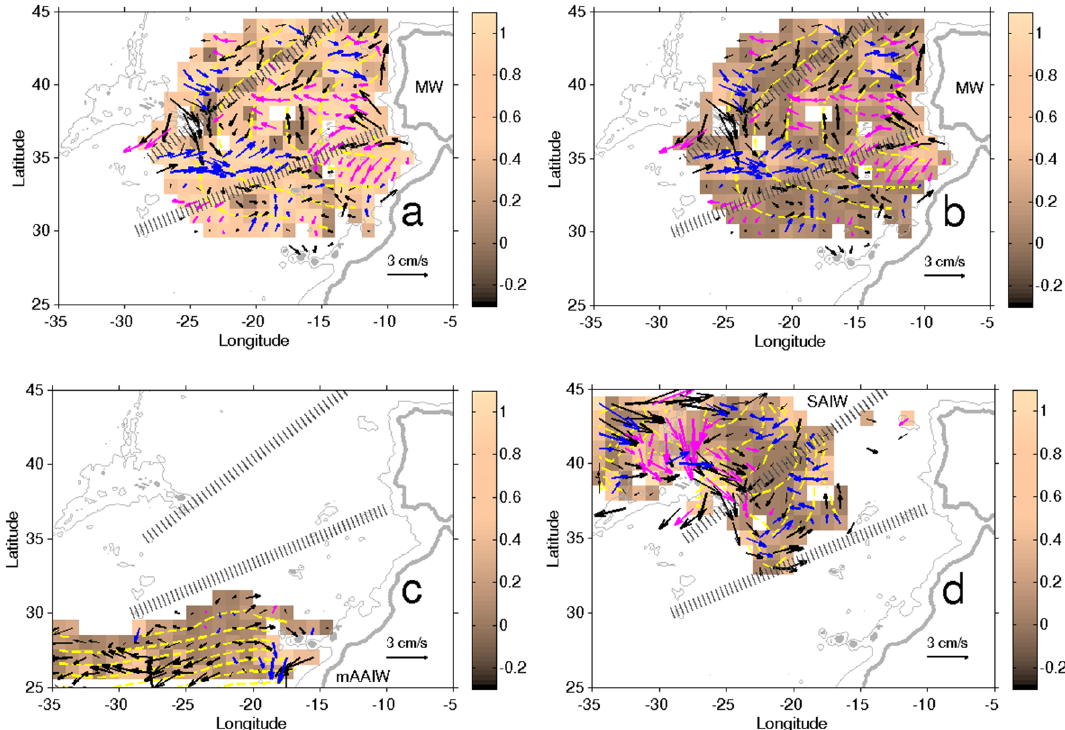
Figure 13. The role of advective and diffusive fluxes in the spreading of water types. Colour in panel (a) is | v/V | over MW; the lighter the shade, the more exact is the advection balanced by the diffusive dispersion of the source water type. Panels (b) , (c) and (d) represent the overall intensity of the diffusive fluxes ( F diff ) for MW, mAAIW and SAIW, respectively. Currents at the core depth of the respective source water type are marked with thin black arrows (the error in definition of the current velocity ranges from 50% to 100%) and thick black/magenta/blue arrows (the error in definition of the current velocity is below 50%). Yellow contours represent isolines of concentration of the respective source water type; see Figs. 5a, 6a and 8a for the absolute values. Black arrows additionally mark the currents that advect concentrations predominantly along the isolines of the source water type concentration, magenta – away from the source water type source (from higher to lower source water type concentration), blue – towards the source (from lower to higher source water type concentration). The boundaries of the three MW cores are marked as dotted grey lines. Solid grey lines present the 2000m isobath and the